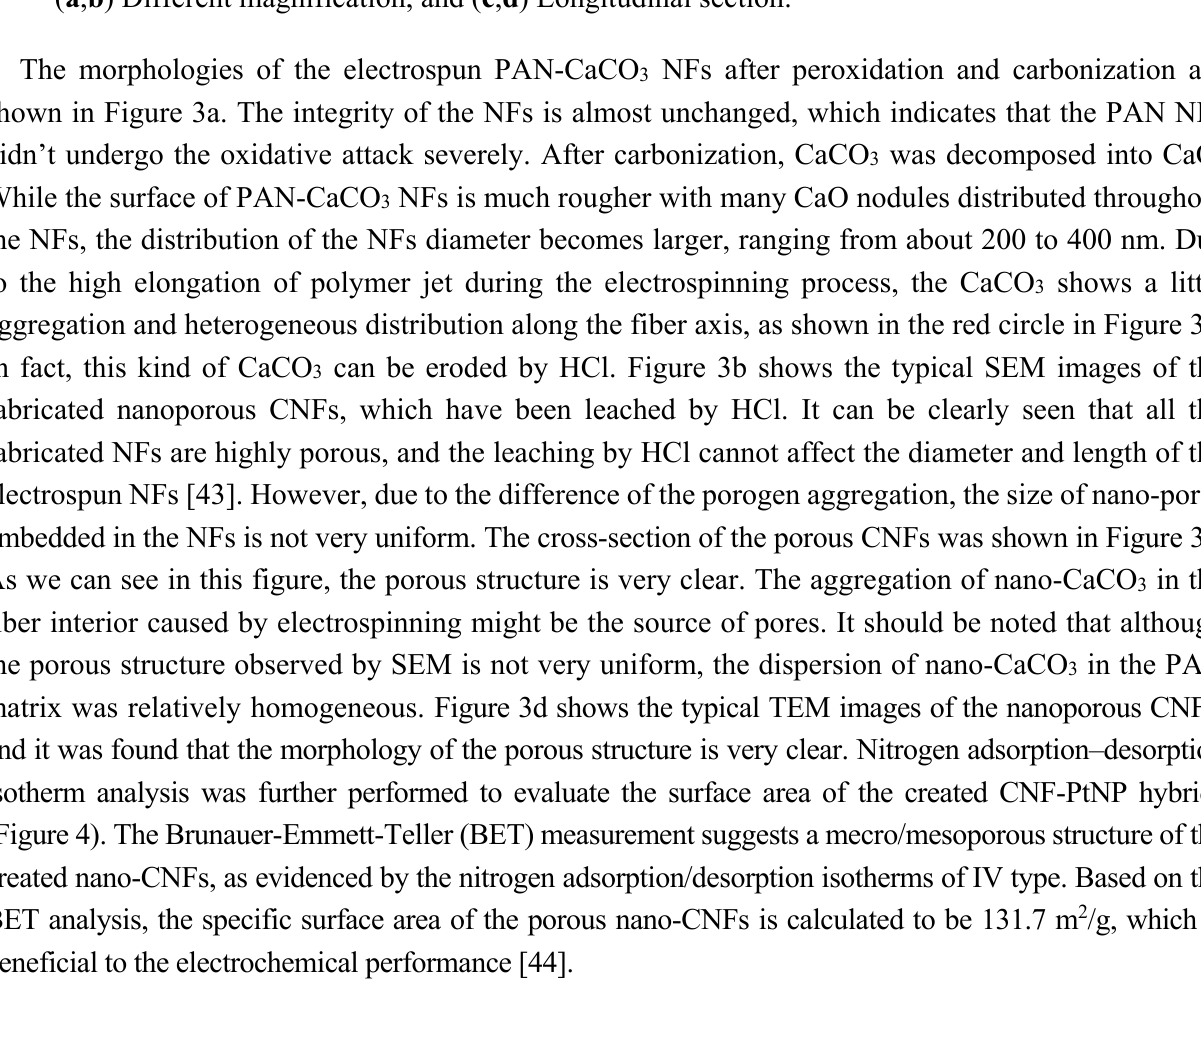
Figure 2. Scanning electron microscopy (SEM) images of electrospun PAN-CaCO 3 NFs: ( a , b ) Different magnification, and ( c , d ) Longitudinal